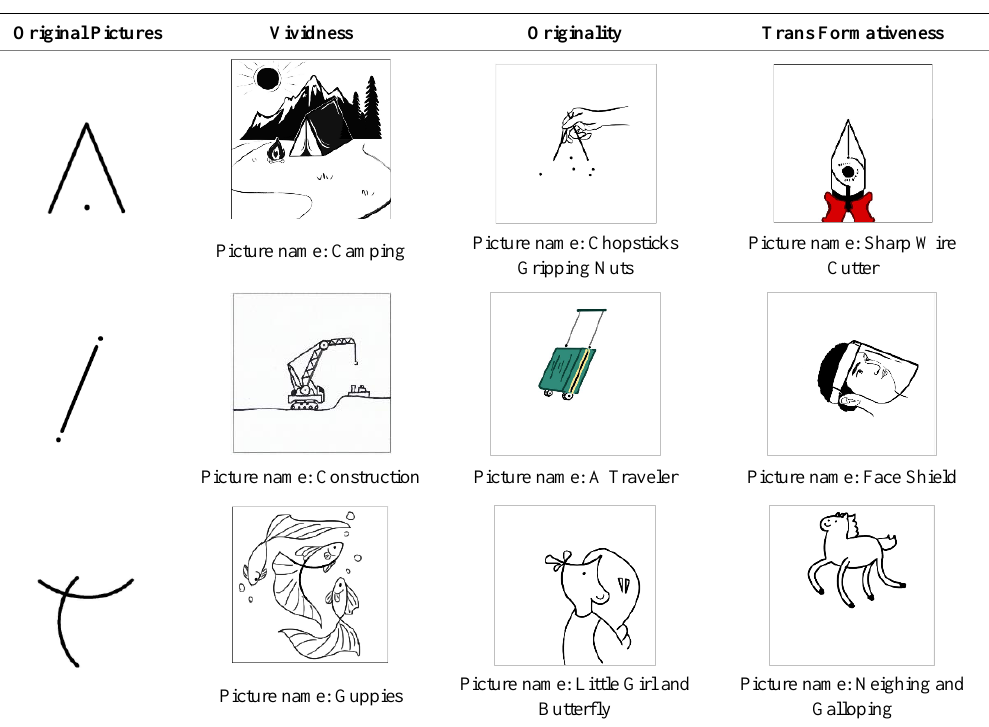
Table 9. Mean values from Multivariate